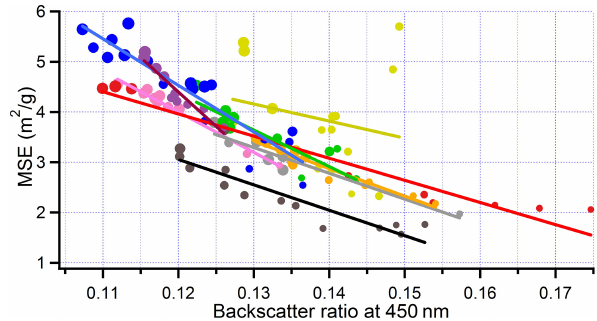
Figure 17. Mass scattering efficiency at 550nm as a function of backscatter ratio at 450nm. Same format as Fig. 13.